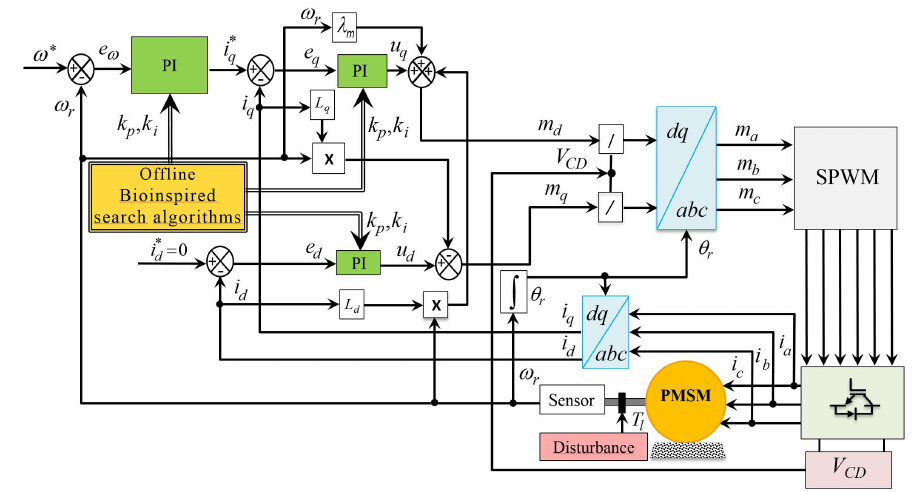
Figure 1. Schematic diagram of the permanent magnet synchronous motor (PMSM) control